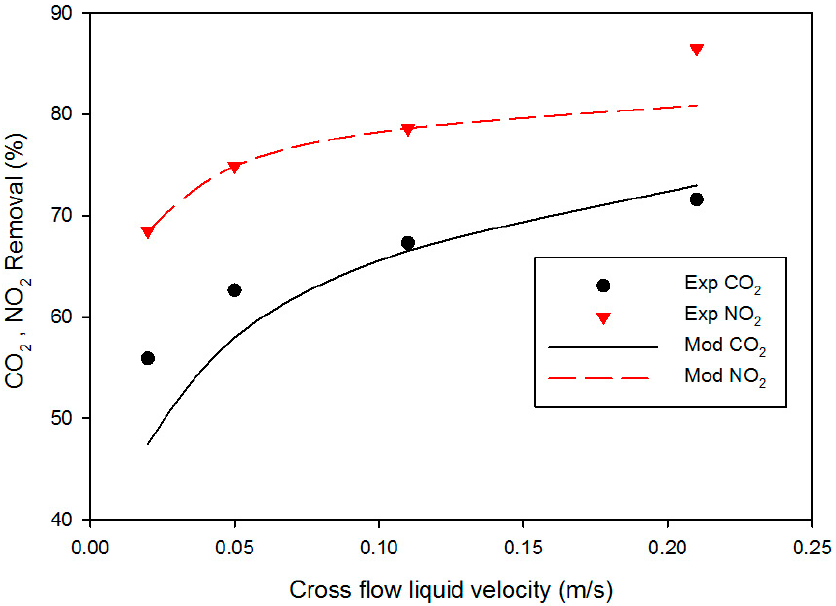
Figure 4. Effect of flow rate of absorbent on the percent removal of undesired gas (gas flow rate = 2.11 m/s, solvent concentration: 0.5 M NaOH; inlet gas composition: 2% CO 2 ; 300 ppm NO 2 ; the balance is N 2 ).